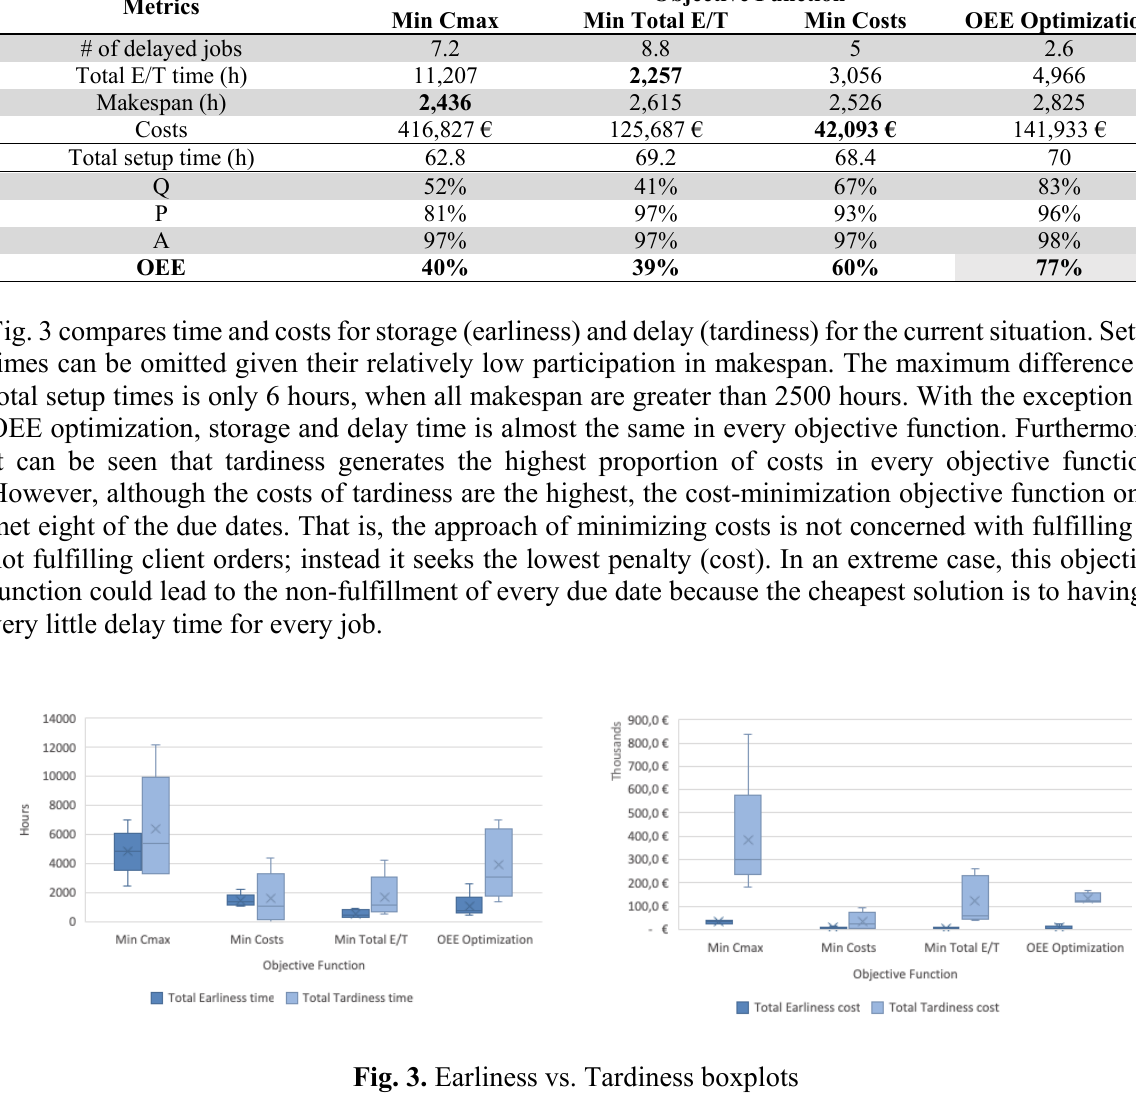
Fig. 3. Earliness vs. Tardiness